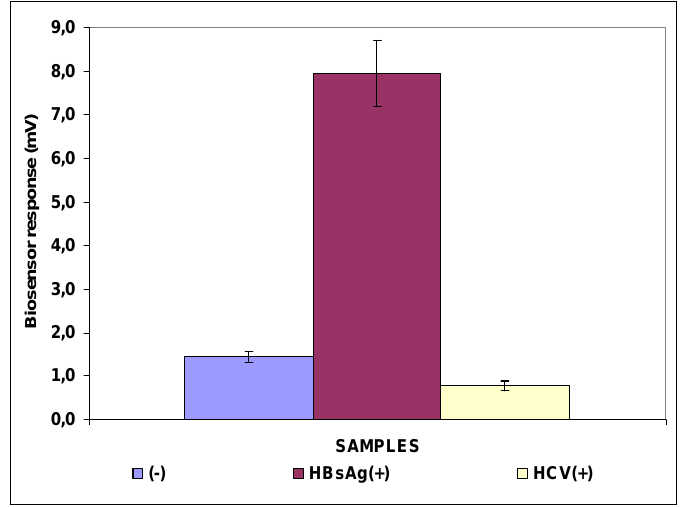
Figure 2. Biosensor response against HBsAg. The sensor is based on Vero cells membrane-engineered with the anti-HBs antibody. Sensor response is expressed as an associated change in the membrane potential of immobilized cells. Error bars represent standard errors of the average value of all replications with each sample ( n = 15 replications for each sample).